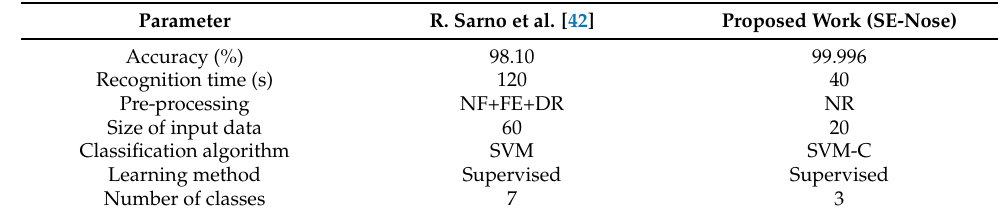
Table 9. Comparison of the results obtained by SE-Nose methodology with R. Sarno et al. [42].